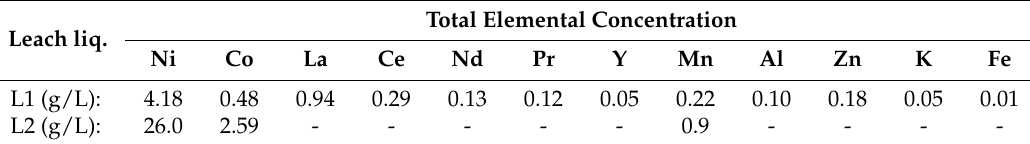
Table 3. Composition of the leach liquors prepared for the nanofiltration experiments. Leach liq.